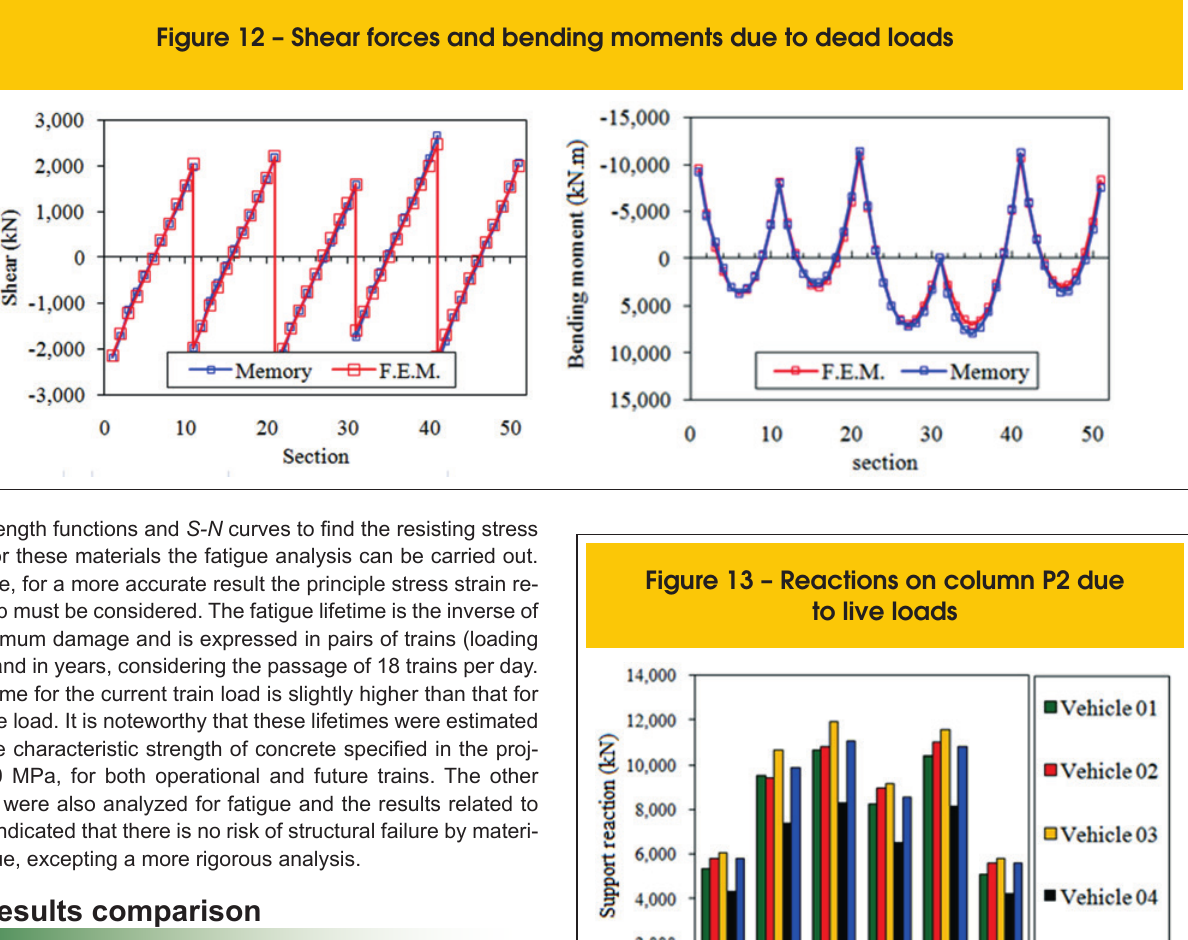
Figure 12 – Shear forces and bending moments due to dead loads